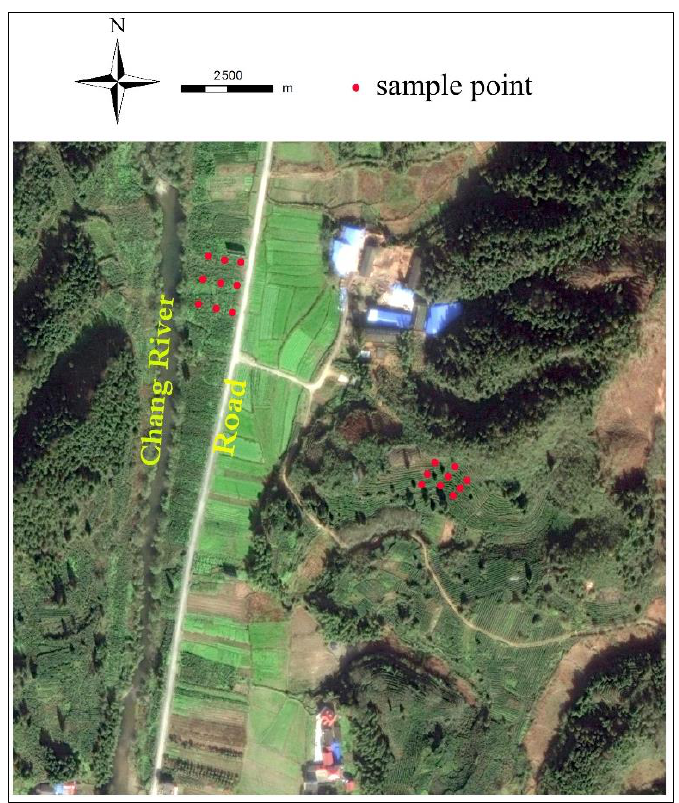
Figure 1. Map of the study area with the sampling points marked.